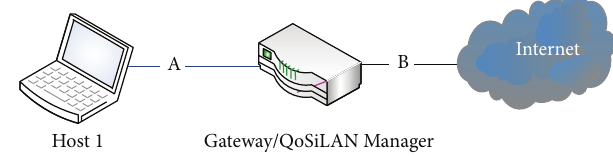
Figure 11: QoSiLAN evaluation